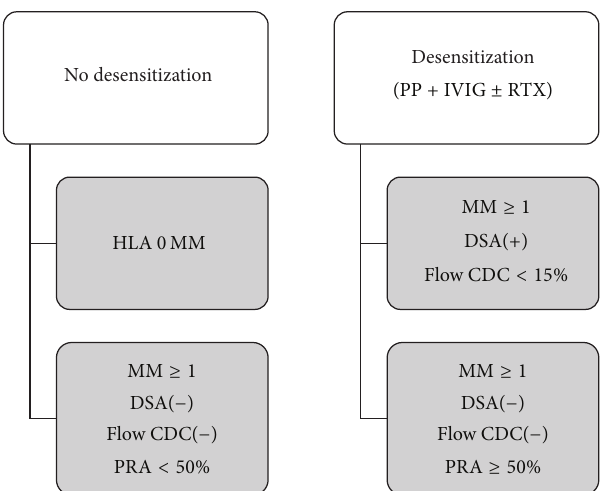
Figure 1: Indications of desensitization therapy for our retransplant patients. No desensitization was initiated if patients had HLA0 MM, or HLA MM ≥ 1, but PRA < 50% with negative DSA and CDC. Desensitization was suggested if patients had (1) HLA MM ≥ 1, DSA positive, and negative or weakly positive flow CDC ( < 15%) or (2) HLA MM ≥ 1 and PRA ≥ 50% with negative DSA and